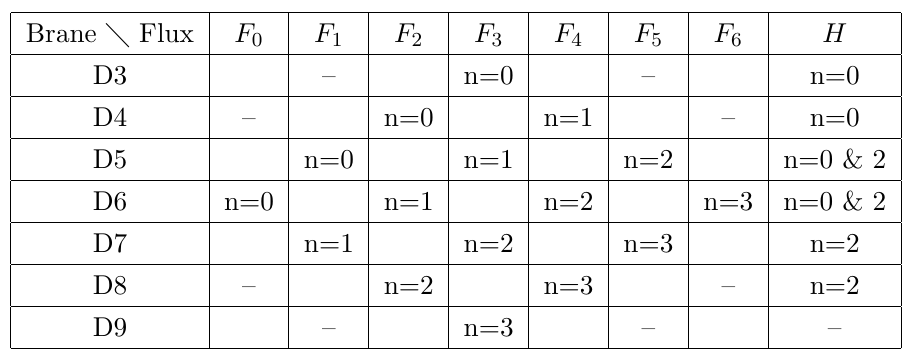
Table 1 . Flux that originate potentially non-vanishing contributions to the gaugino mass. The dashes indicate components that are projected out due to the calibration of the